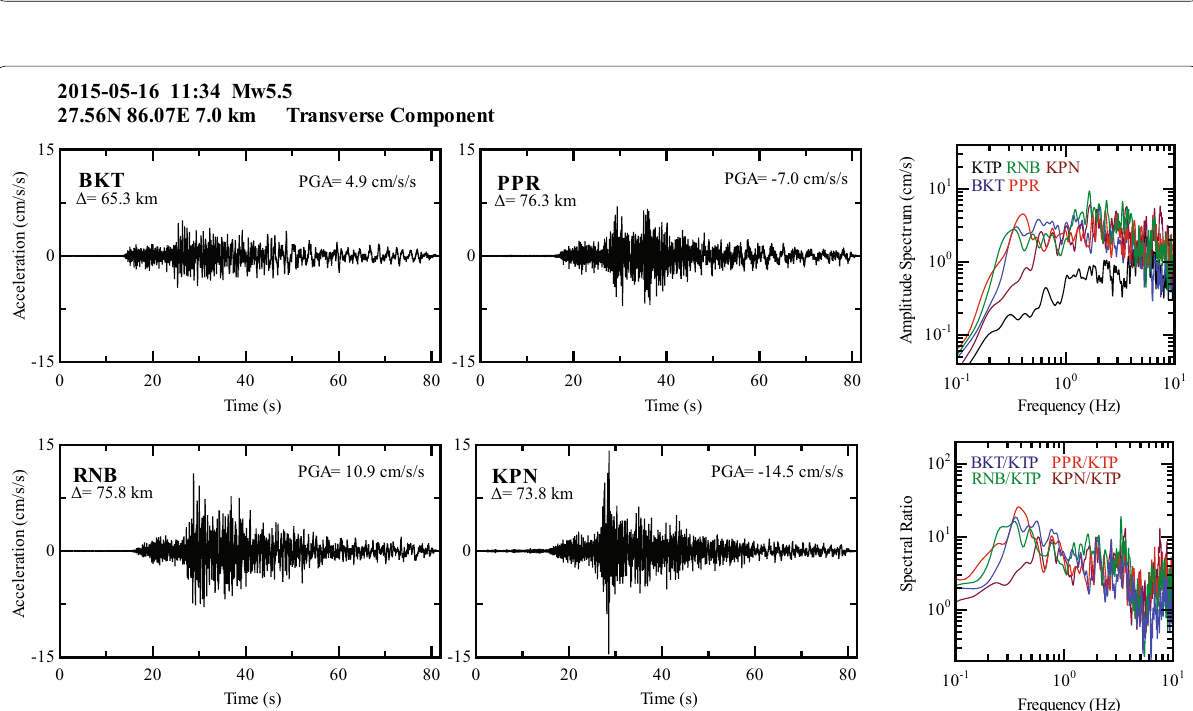
Fig. 6 Acceleration waveforms, Fourier spectra, and spectral ratios of the Mw5.5 aftershock for the transverse component. This aftershock occurred on the same day as the largest aftershock